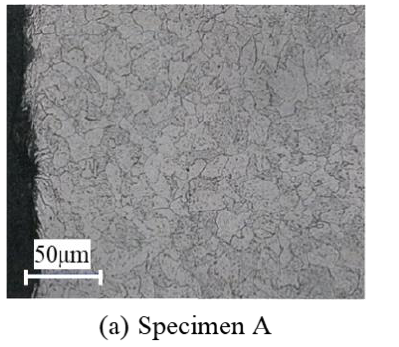
Figure 4. Microstructure observation.